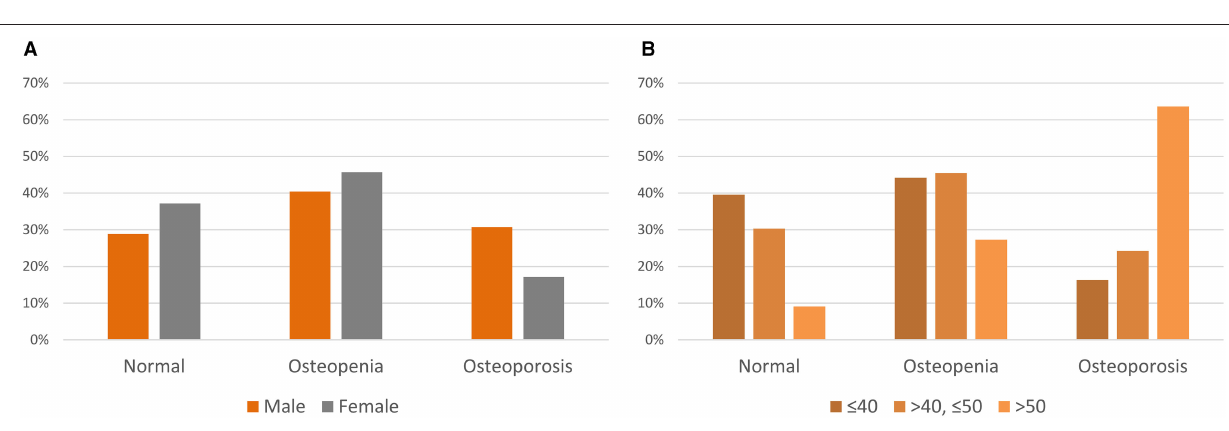
FIGURE 2 | T -scores of adults with cerebral palsy. (A) T -scores by sex. (B) T -scores by age